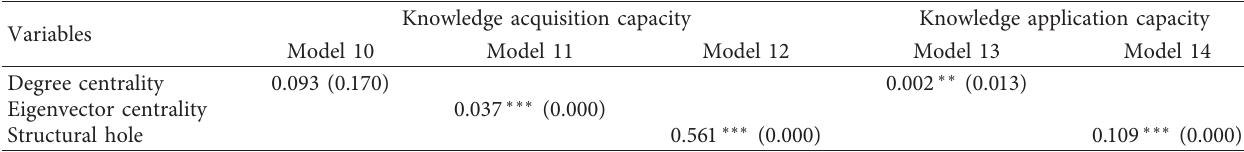
Table 7: The regression results of hypothesis 3.